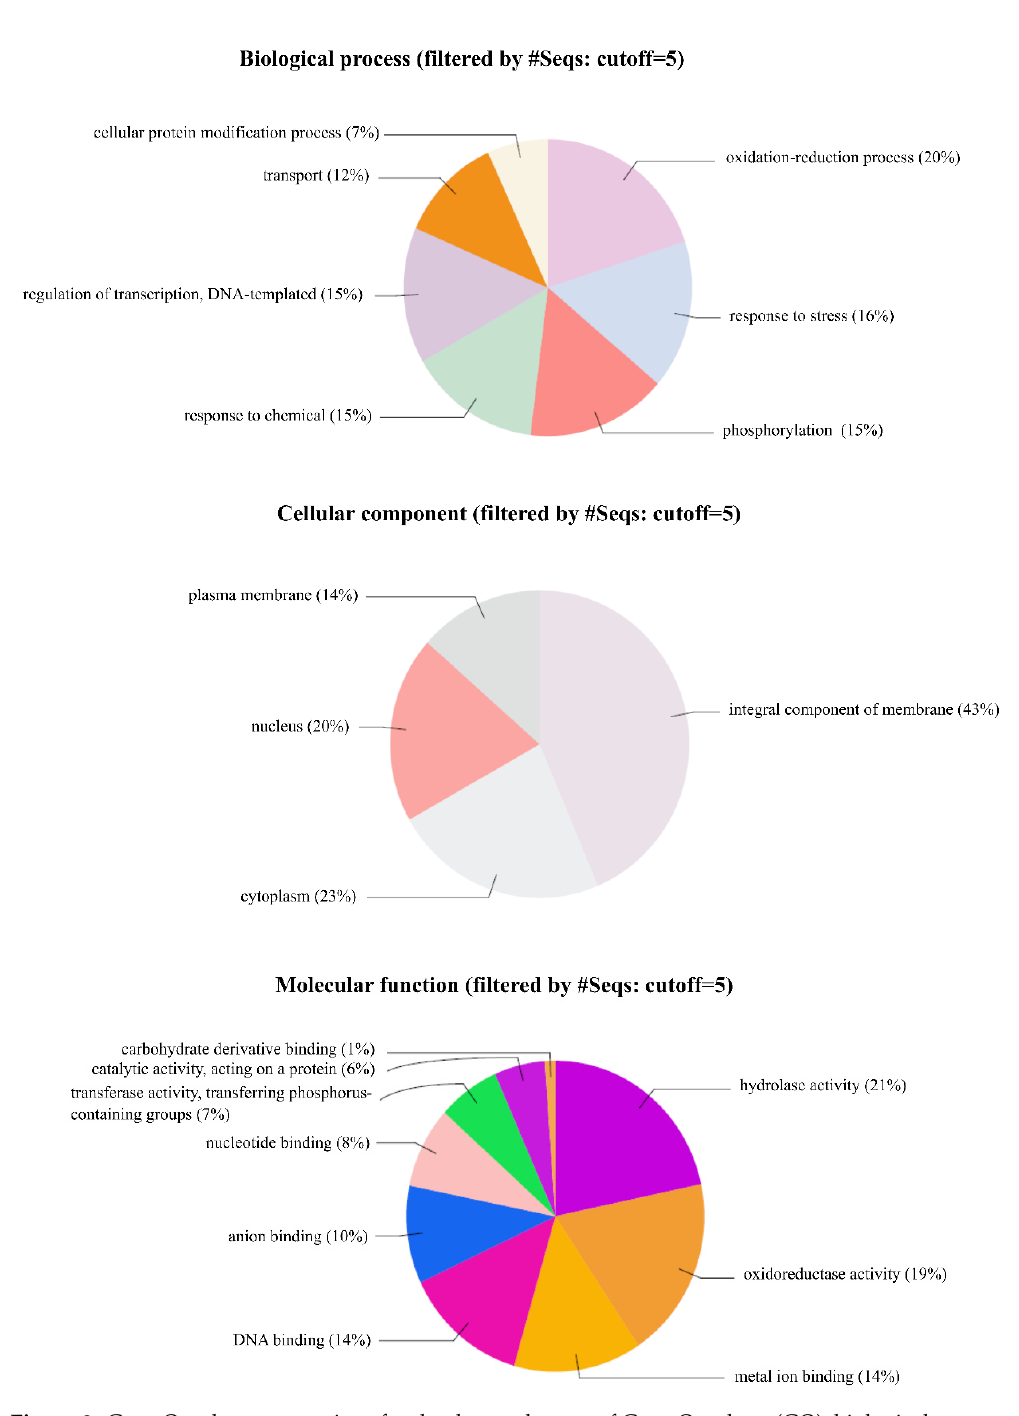
Figure 3. Gene Ontology annotations for the three sub-trees of Gene Ontology (GO): biological process, molecular functions and cellular components. Numbers indicate the percentage of protein-coding raspberry transcripts assigned to each category. Plots were made using Blast2GO/Omicsbox. The frequencies of GO terms between prickle-free plants and prickled plants were then compared using GO information from all the genes in the genome. This was compared with the